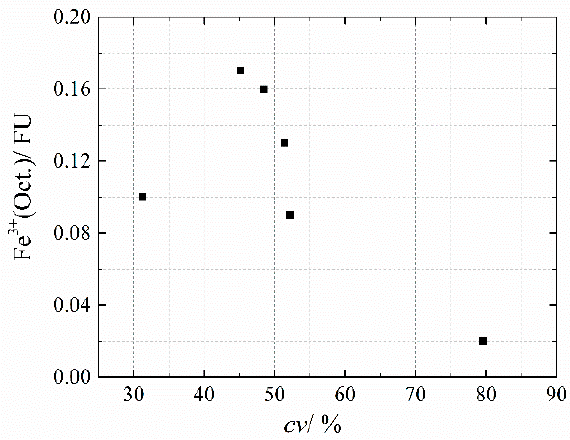
Figure 4. Relationship between the proportion of cv layers and the octahedral iron content.